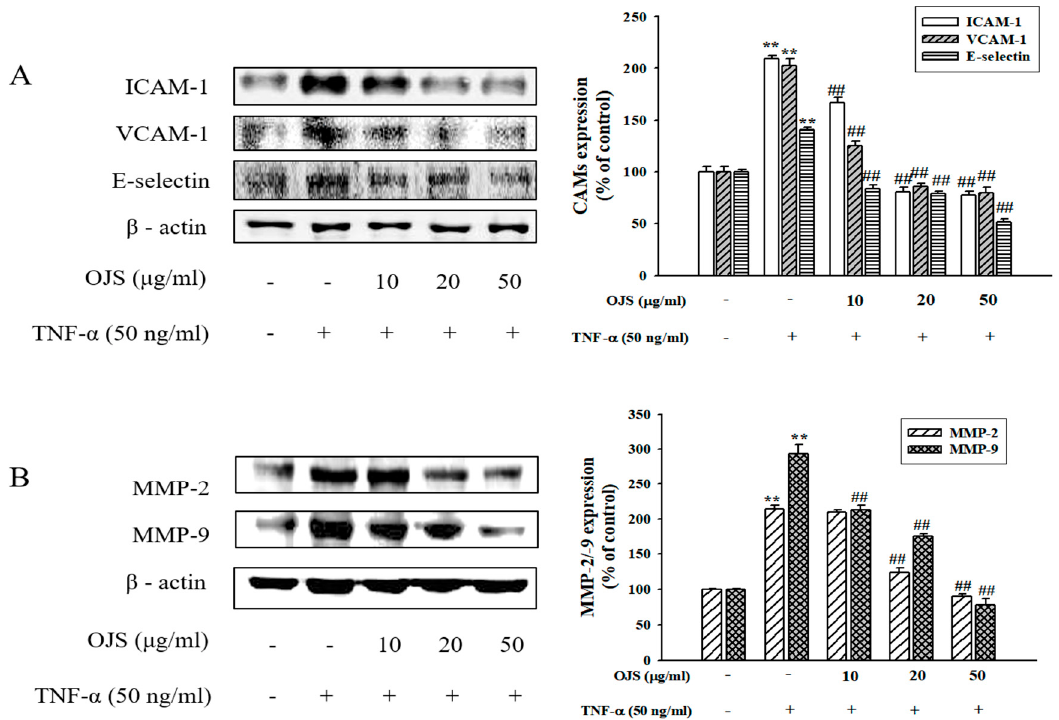
Figure 7. Effects of OJS on TNF- α -induced protein expressions of cell adhesion molecule and MMPs expression. Western blot analysis of ICAM-1, VCAM-1, and E-selectin expression. The blots are representative of three independent experiments and densitometric quantification of ICAM-1, VCAM-1, and E-selectin ( A ). Western blot analysis of MMP-2/-9 whole protein ( B ). Data are presented as means ± S.E. ** p < 0.01 vs. control; ## p < 0.01 vs. TNF- α alone.